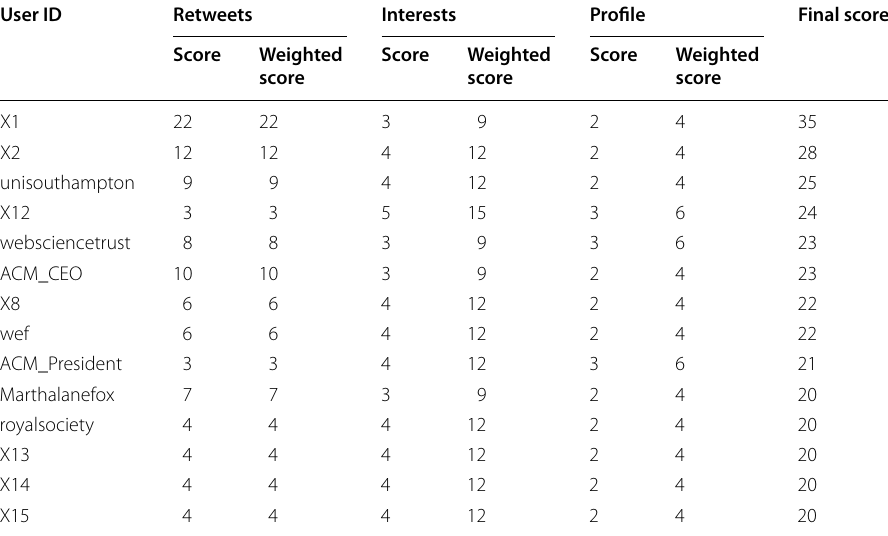
Table 6 Personality based configuration results break-down of scores User